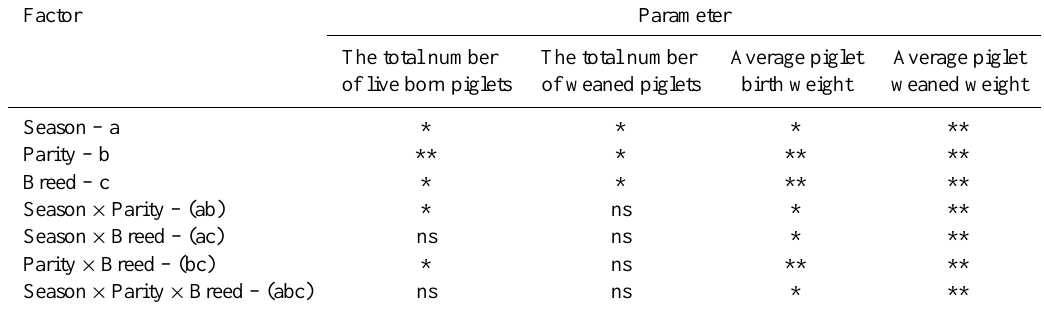
Table 1. The impact of the season, parity, breed and interaction of these factors on selected reproductive performance parameters of sows. Factor Parameter The total number The total number Average piglet Average piglet of live born piglets of weaned piglets birth weight weaned weight Season – a * * * ** Parity – b ** * ** ** Season × Parity – (ab) Season × Breed – (ac) Season × Parity × Breed – (abc)